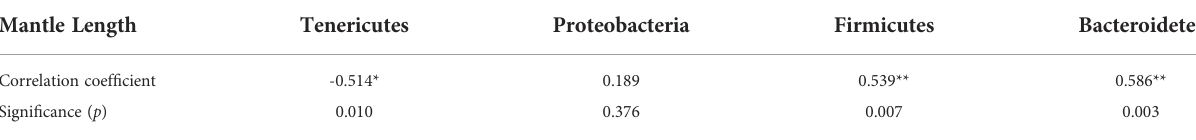
TABLE 1 Correlation analysis between the mantle length of Sthenoteuthis oualaniensis and the relative abundance of dominant intestinal bacteria at the phylum level. Mantle Length